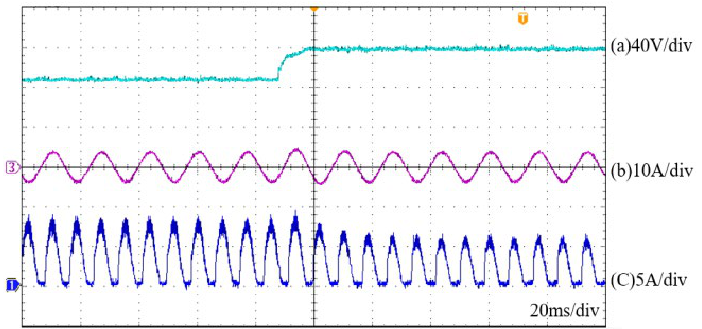
Figure 15. Experimental results of the BBI under the transient of input DC voltage variation, ( a ) input DC voltage, ( b ) output current, ( c ) current of inductor L 1 .